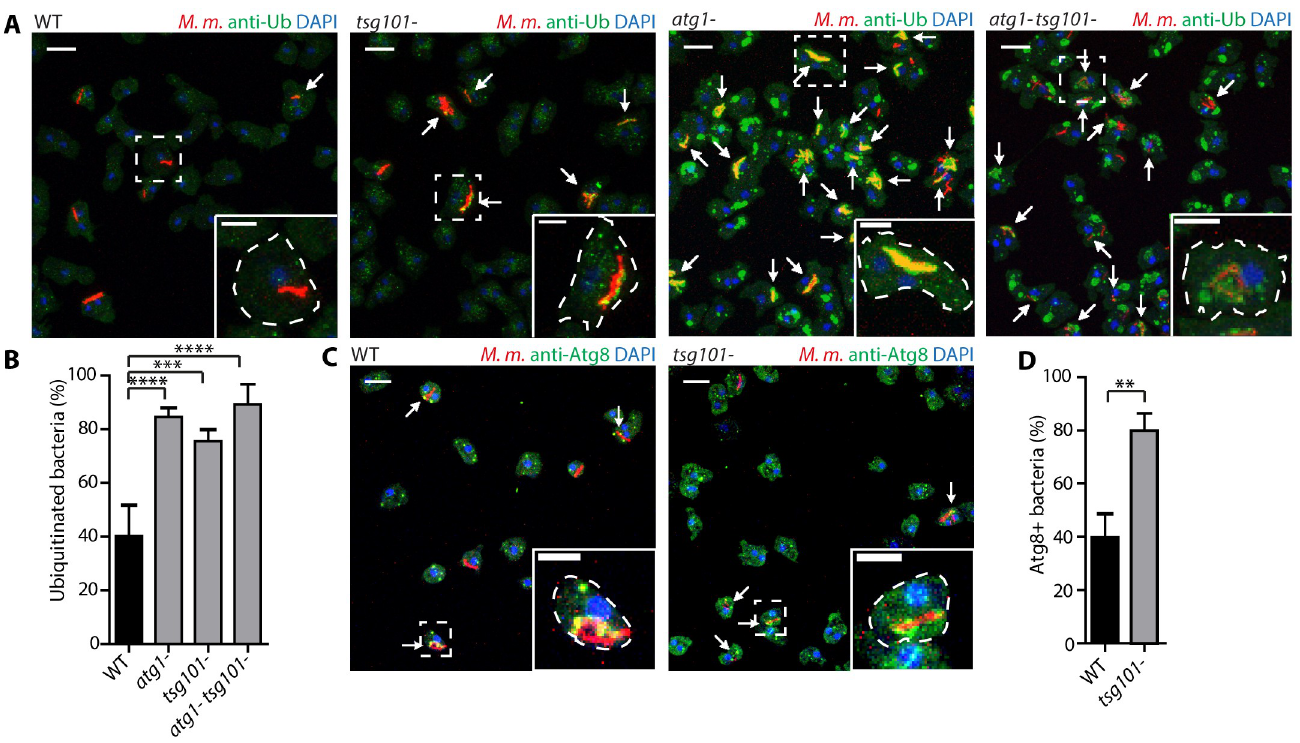
Fig 7. Deficiency in membrane repair leads to earlier escape of M . marinum from the MCV. (A) D . discoideum wt or mutant ( atg1 -, tsg101 -, atg1 - tsg101 -) were infected with M . marinum and fixed for immunostaining at 8 hpi ( M . marinum in red, ubiquitin in green, DAPI in blue). Arrows point to ubiquitinated bacteria. Scale bars, 10 μ m and 5 μ m for the insets. (B) Quantification of the proportion of ubiquitinated bacteria or bacterial microcolonies. The plot shows the mean and standard deviation (WT N = 6, n = 306; atg1- N = 3, n = 251; tsg101 - N = 3, n = 93; atg1 - tsg101 - N = 3, n = 215). (C) Wt or tsg101- cells were infected with M . marinum and fixed for immunostaining at 8 hpi ( M . marinum in red, Atg8 in green, DAPI in blue). Arrows point to bacteria decorated with Atg8. Scale bars, 10 μ m and 5 μ m for the insets. (D) Quantification of the proportion of bacteria or bacterial microcolonies decorated with Atg8. The plot shows the mean and standard deviation. (WT N = 3, n = 70; tsg101- N = 3, n = 63). Two-tailed t -tests (D) or two-way ANOVA and post hoc Fisher’s LSD tests were performed (B).